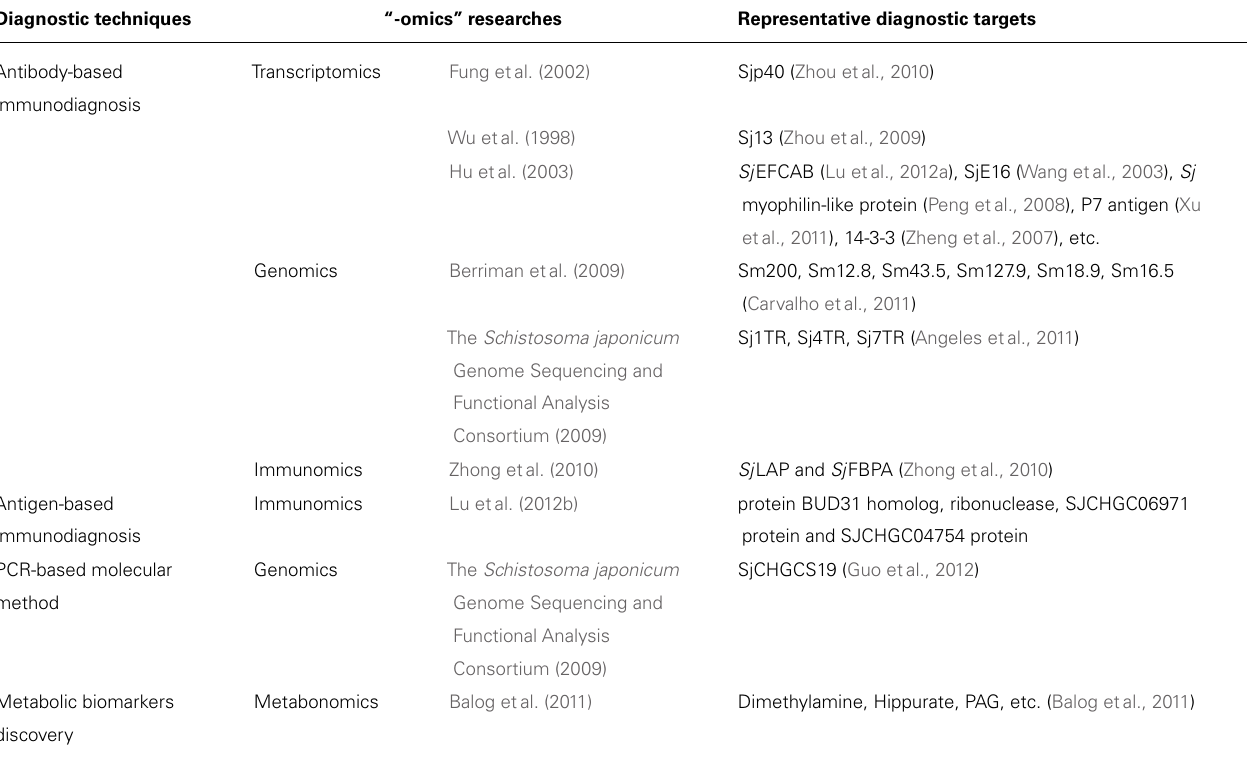
Table 1 |An overview of “-omics” researches’ contribution to the revelation of novel schistosomiasis diagnostic targets. Diagnostic